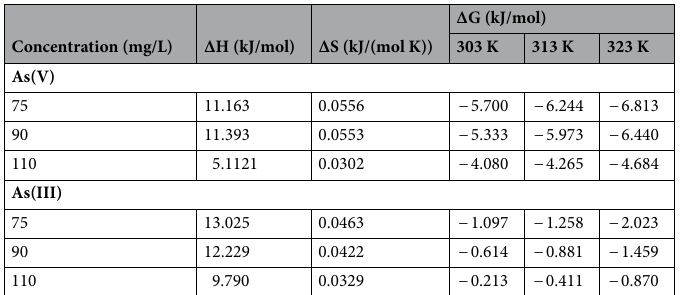
Table 5. Thermodynamics parameters for As(V) and As(III) adsorption onto iron hydroxide nanopetalines at pH 4.0.